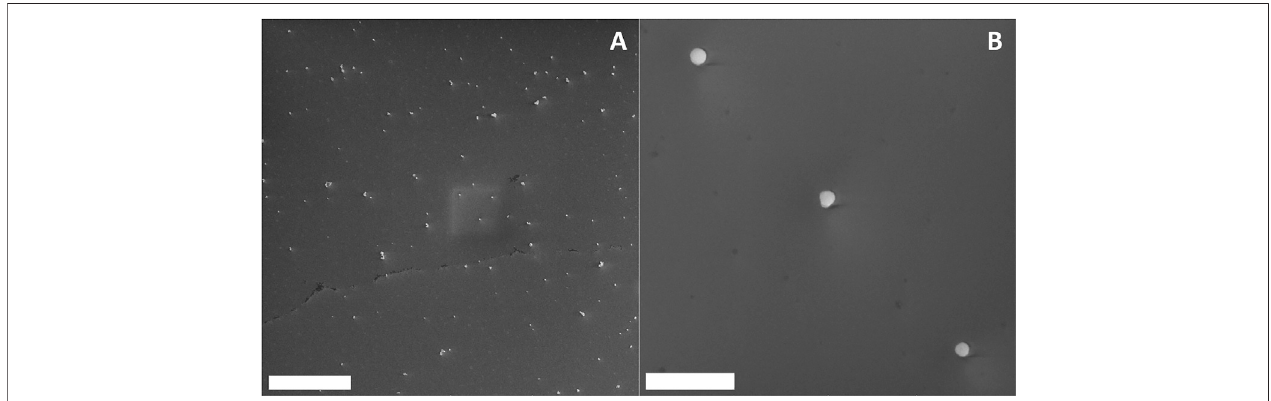
FIGURE 8 | Large-scale (46.4 µm × 46.4 µm) Scanning Electron Microscopy (SEM) of upconverting KGd 3 F 10 NPs deposited on a coverslip after spin-coating a dilutedispersionofNPsonit(scalebar:10 µm) (A) .Small-scalescanning(4.64 µm × 4.64 µm),whereitispossibletochoosesingleNPslocatedfarawayfromanyother NP (at least 3.2 µm, about 10 × the theoretical resolution of the optical system) to perform the single NP measurements (scale bar: 1 µm) (B)